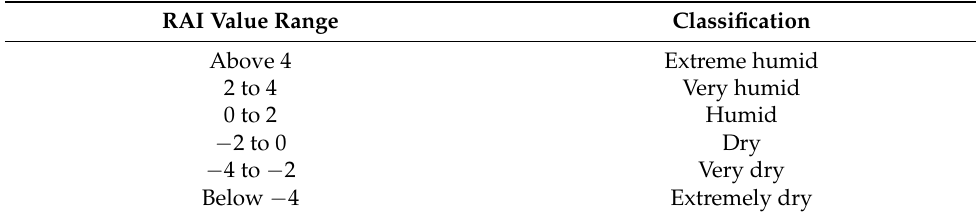
Table 2. Categorized rainfall based on RAI values. RAI Value Range Classification Above 4 Extreme humid 2 to 4 Very humid 0 to 2 Humid − 2 to 0 Dry − 4 to − 2 Very dry Below − 4 Extremely